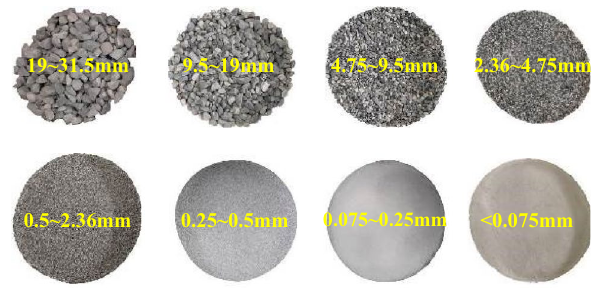
Figure 1. Eight groups of soil particles with different grain sizes.